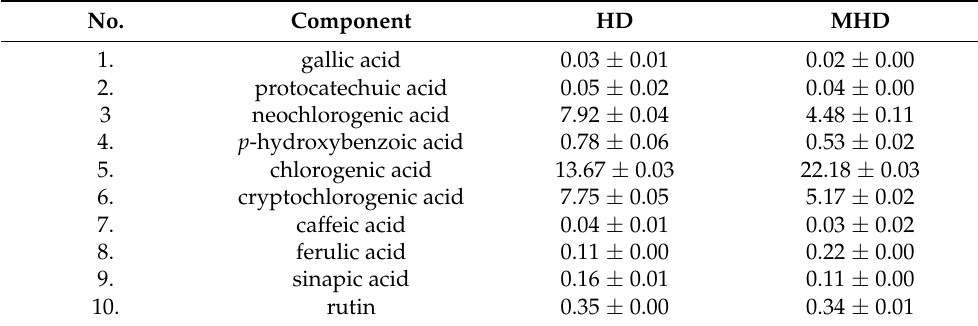
Table 3. Phenolic profile (mg/g of dry extract) of residual wastewater extracts after essential oil extraction by hydro-distillation (HD) and microwave-assisted hydro-distillation (MHD) detected by high performance liquid chromatography